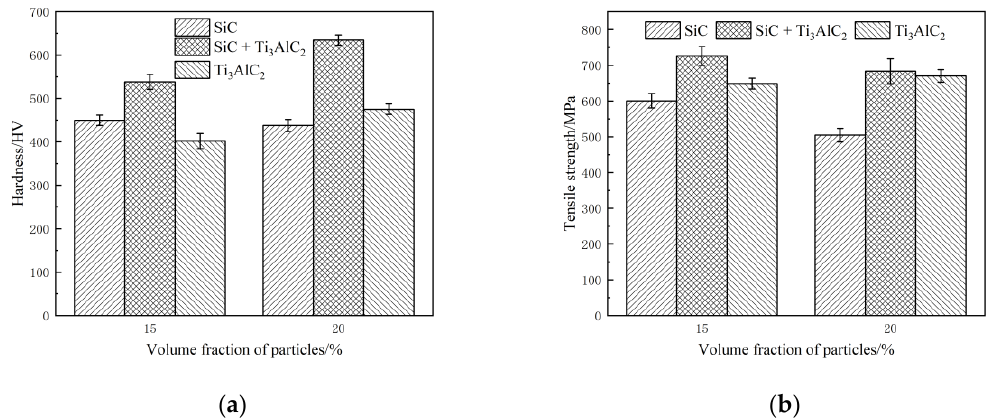
Figure 8. The hardness and tensile strengths of the as-prepared samples. ( a ) hardness; ( b ) tensile strength.